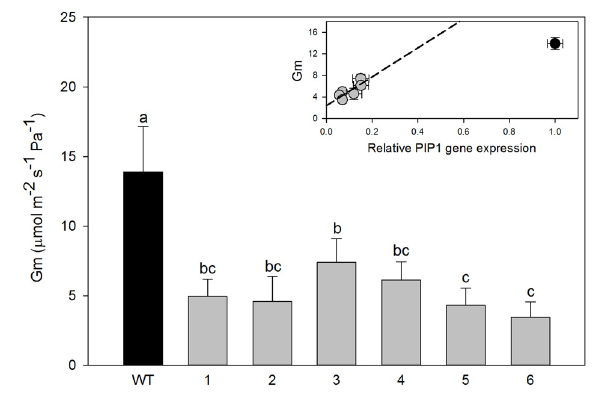
FIGURE 3 | Mesophyll conductance to CO 2 (g m ) in wild-type and transgenic lines. Data are means of g m for all available plants from transgenic lines ( n = 3–8); the error bars represent SD corrected for the multiple comparisons. One Way ANOVA test suggests significant differences between wild-type and transgenic lines ( P < 0 . 001). Letters denote homogeneous groups based on Fisher LSD method. Inset figure; g m values of lines were plotted for PIP1 relative expression. Bars denote SE. Black circle, wild-type plants; gray circles, transgenic